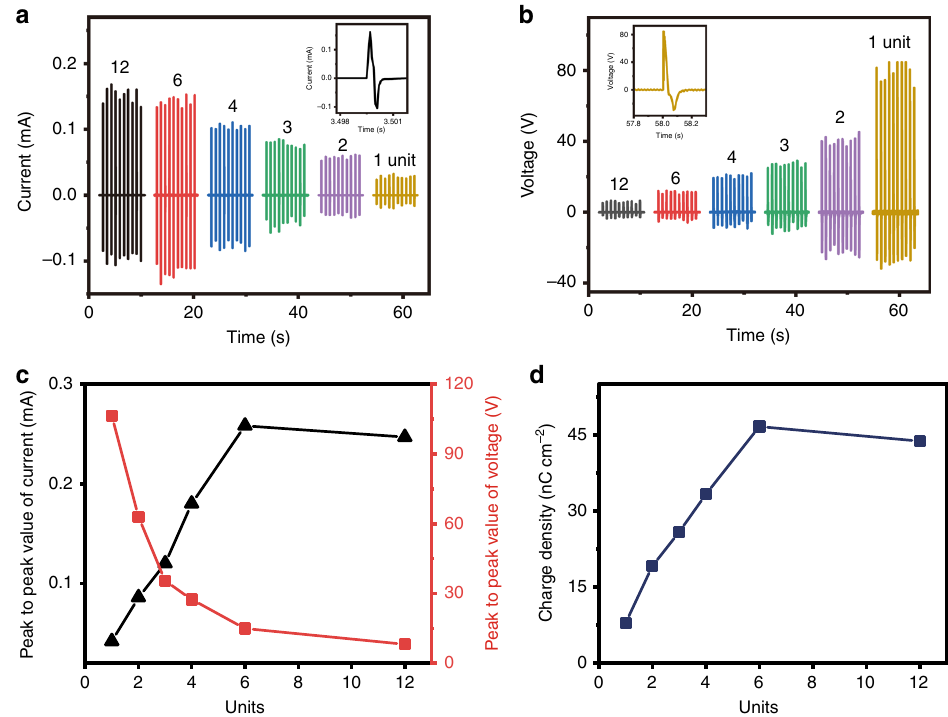
Fig. 4 Output performance of IENGs with different units. Piezoelectric layer is constructed by 12 composite thin fi lms, and then divided into 1, 2, 3, 4, 6 and 12 units by different pairs of intercalation electrode. Adjacent units obtain opposite polarization direction. a , b Output current and output voltage of each case. Insets are the enlarged views of output current generated by 12 units and output voltage by 1 unit, respectively. c The trend of peak to peak values of output current and voltage in a and b with the increase of units. d The trend of charge densities calculated from current signals with the increase of